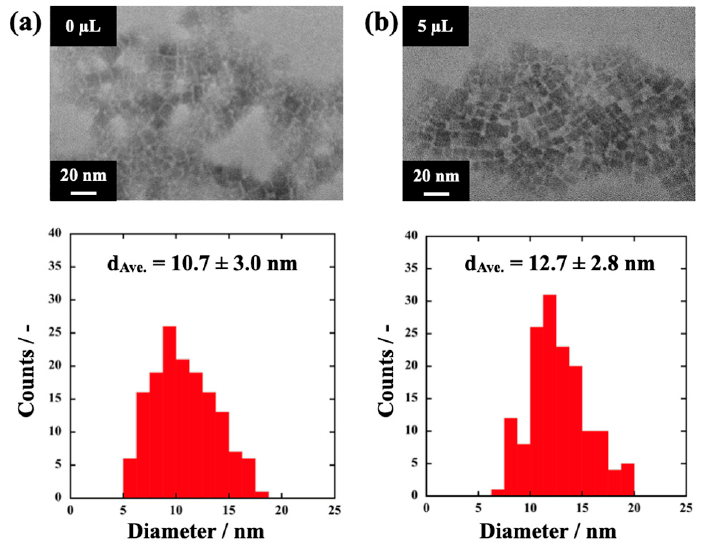
Figure 2. TEM images and size histogram of MAPbBr 3 PeQDs ( a ) without water and ( b ) water-assisted (5 µL).